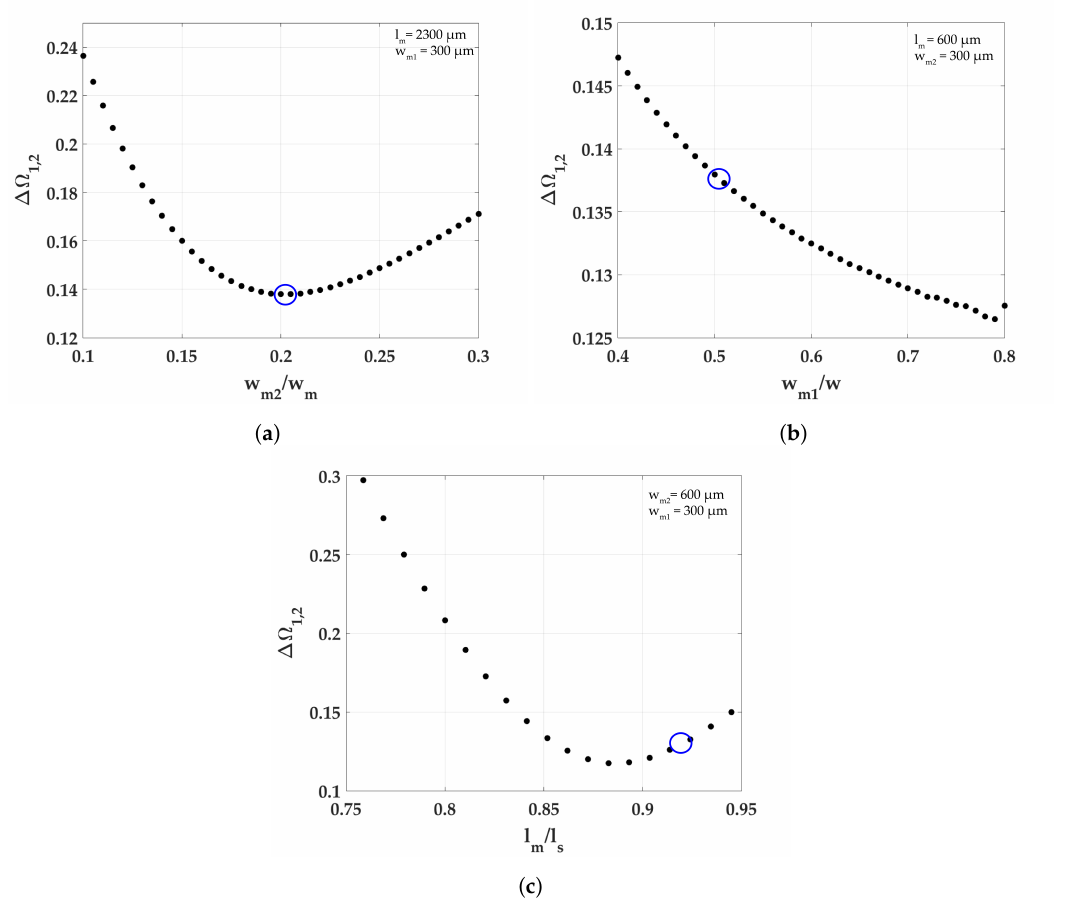
Figure 4. Simulated variation of ∆Ω 1,2 with respect to: ( a ) w m 2 , width of the free end; ( b ) w m 1 , width of fixed end; and ( c ) l m , length of the middle beam. The blue circle denotes the values of M-shape on the respective